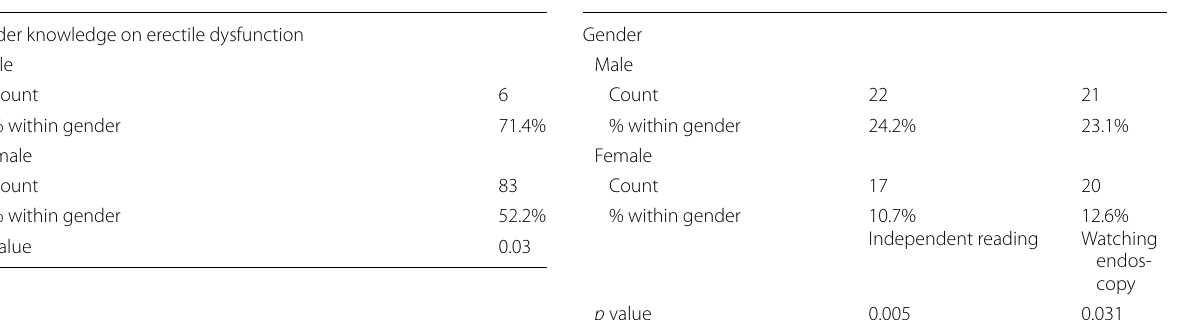
Table 4 Gender differences regarding best modality